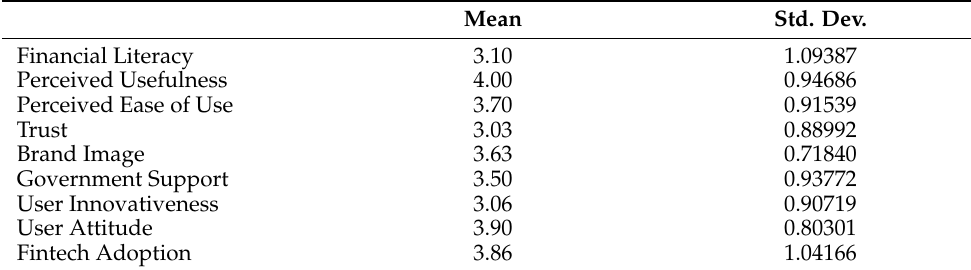
Table 11. Mean and Standard Deviation of Research Variables.